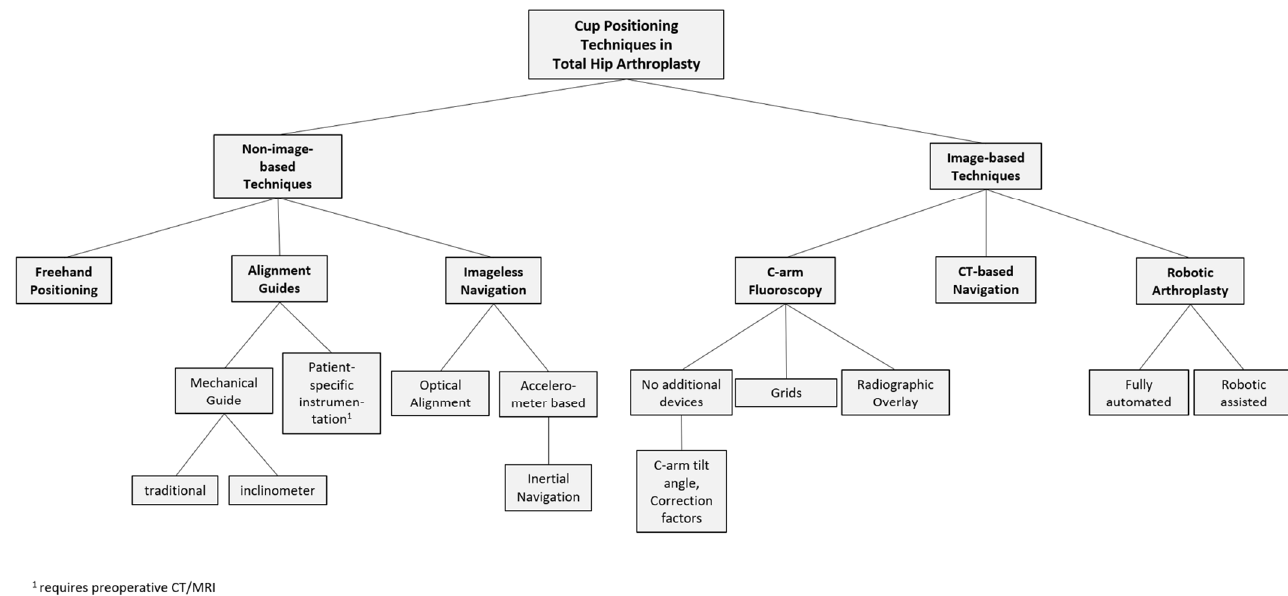
Figure 1. Organizational diagram showing an overview of various cup positioning techniques in total hip arthroplasty. Patient-specific instrumentation is listed with alignment guides, however, it requires preoperative imaging to manufacture the instrumentation. See the main text for detailed information on the techniques.